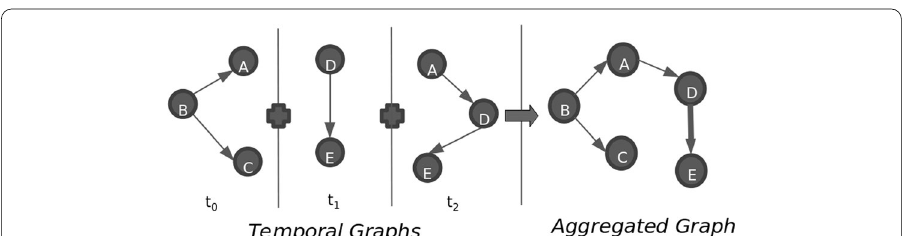
Fig. 1 Overview of our methodology